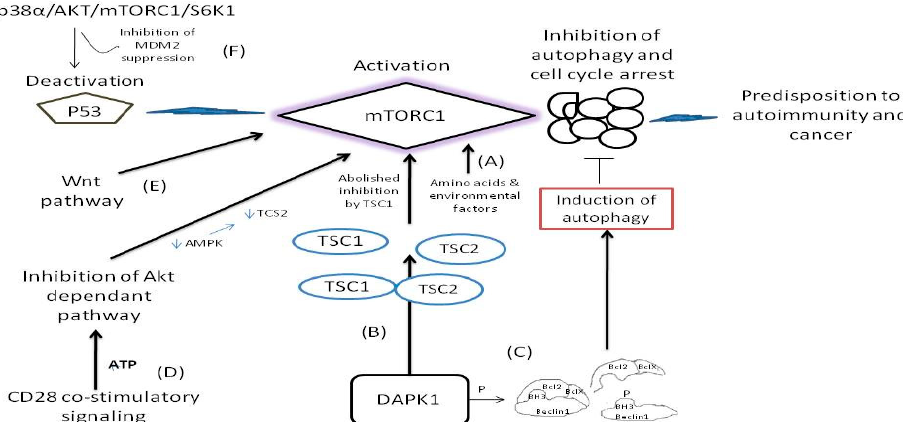
Figure 2. The pathways where mTORC1 remains activated or its function is bypassed and predispose to disease. ( A ) The mTOR remains activated by insulin and insulin like molecules and nutrients such as glucose, amino acids and other environmental factors [48,56,57]. ( B ) Interaction of DAPK1 with TSC1 causes inhibition of mTORC1 suppression. Following, the liberated TSC2 from TSC1/TSC2 complex activates mTOR [58–60]. ( C ) Phosphorylation of Beclin 1 in its BH3 domain causes dissociation of Beclin 1 from its inhibitors Bcl-X(L) and Bcl-2 to activate autophagy [61]. ( D ) During CD 28 signaling the Akt kinase activity is repressed therefore alleviating mTORC1 inhibition [89,90]. ( E ) Wnt pathway activates directly the mTORC1 bypassing GSK3 β inhibition [88]. (F) Deactivation of p53 function pause breaks for mTROC1 activity [54].